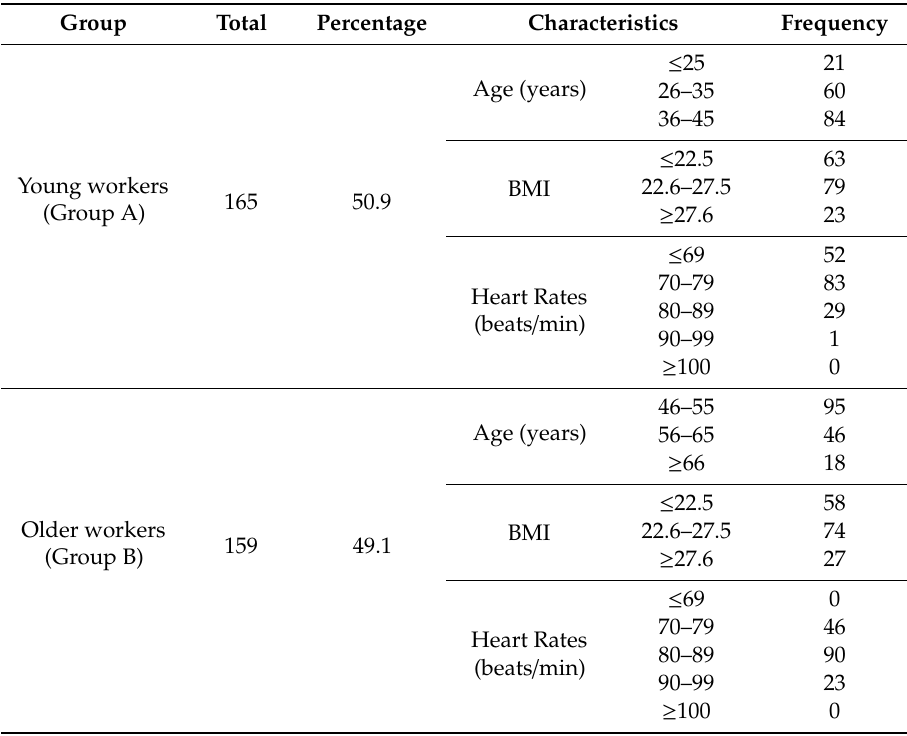
Table 4. Participants’ demographic characteristics ( N =